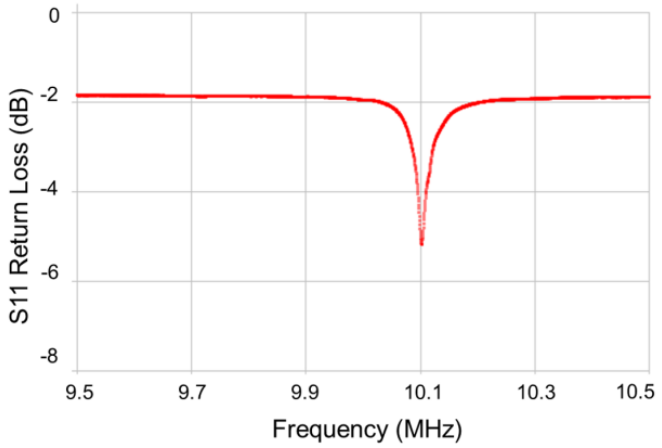
Figure 2. Resonance frequency analysis of the piezo ceramic transducer. Figure 1. The 3D printed and assembled microfluidic device. ( a ) Schematic depiction of the device geometry. ( b ) Actual picture of the acoustic device.